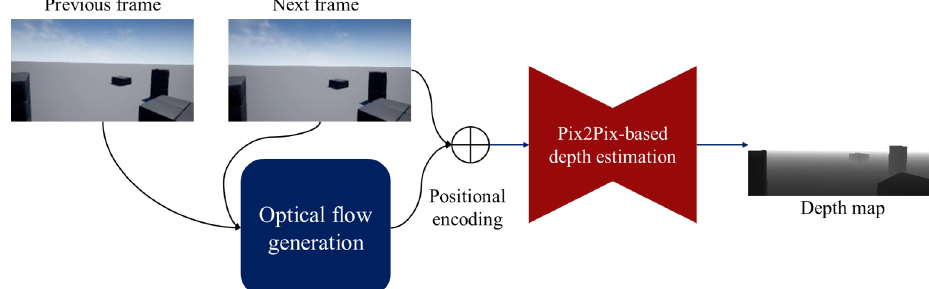
Figure 2. System overview of the proposed